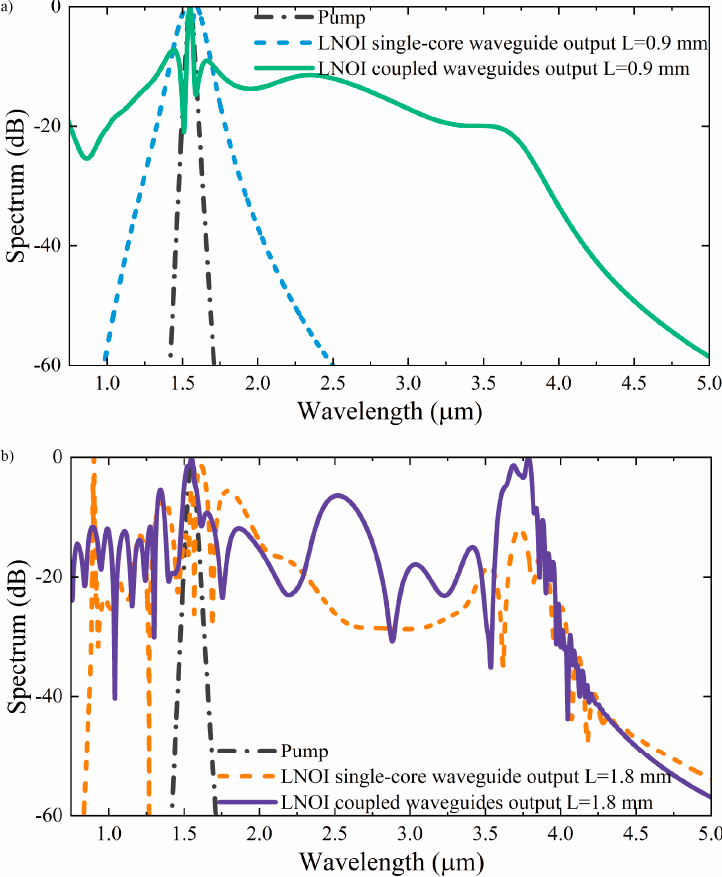
Figure 5. ( a ) The instantaneous spectral profiles of the initial pump, and the single-core and the dual-coupled waveguides of x -cut LNOI at L = 0.9 mm. The full-width at half maxima of the pump is fixed to τ FWHM = 75 fs. ( b ) The instantaneous spectral profiles of the initial pump, and the single-core and the dual-coupled waveguides of x -cut LNOI at L = 1.8 mm. The full-width at half maxima of the pump is fixed to τ FWHM = 75 fs.